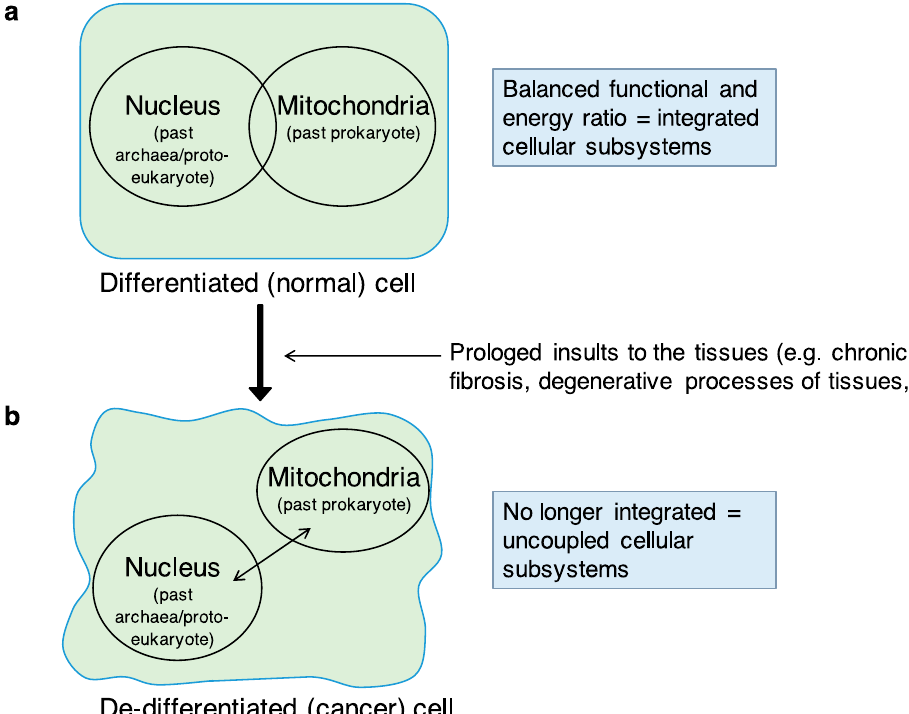
Figure 1. The balanced integration of the two endosymbiotic subsystems, (i) information = nucleus (the ancestral ‘‘archaea”) and (ii) energy = mitochondria (the ancestral ‘‘prokaryote”) within the eukaryotic cell is essential to maintain the differentiated cell status. The transition from ( a ) the differentiated (normal) cell to ( b ) the de-differentiated (cancer) cell as a consequence of a prolonged insult to the tissues (e.g., chronic inflammation, fibrosis, degenerative processes of tissues, etc.) could be caused by the progressive breakdown (or uncoupling) of the two endosymbiotic subsystems integration. The resulting de-emergence of the “eukaryotic cell system” with the re-emergence of the archaea-like and prokaryotic-like subsystems, featuring uncoordinated behaviors, would lead to a sort of “cellular regression” towards ancestral or atavistic biological functions and behaviors similar to those of protists or unicellular organisms in general.